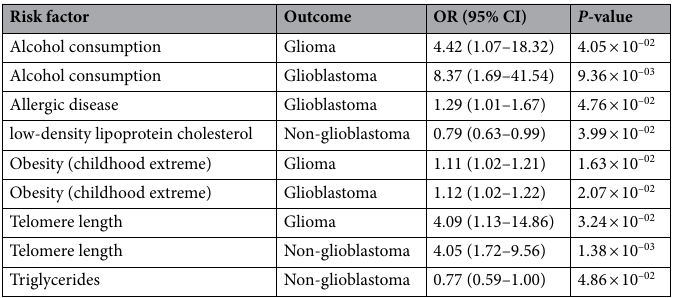
Table 1. Summary of the risk factors identified in a previous study and their effect on glioma or glioma subtype. OR change in glioma risk per standard deviation change in risk factor, 95% CI 95% confidence intervals, p-value p-value for the observed